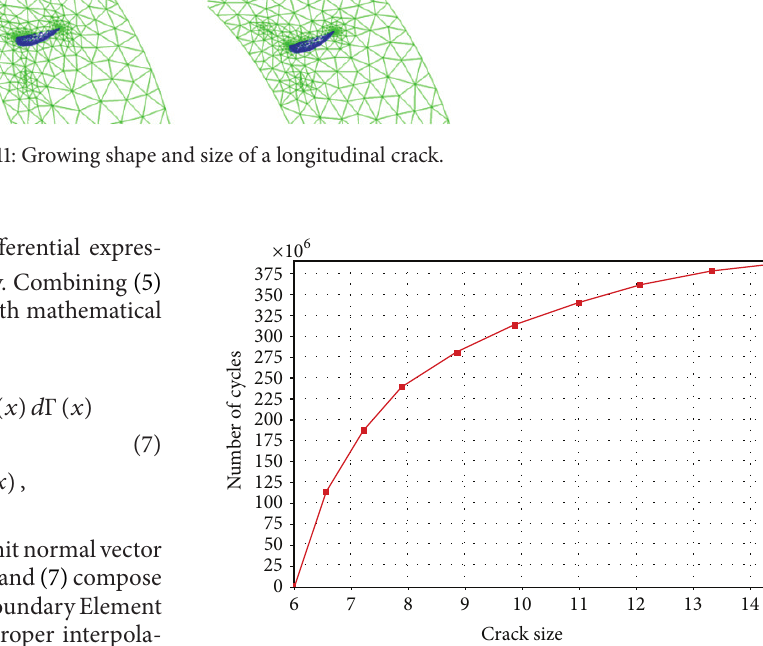
Figure 12: Relationship of loading cycle and crack size of a longitudinal